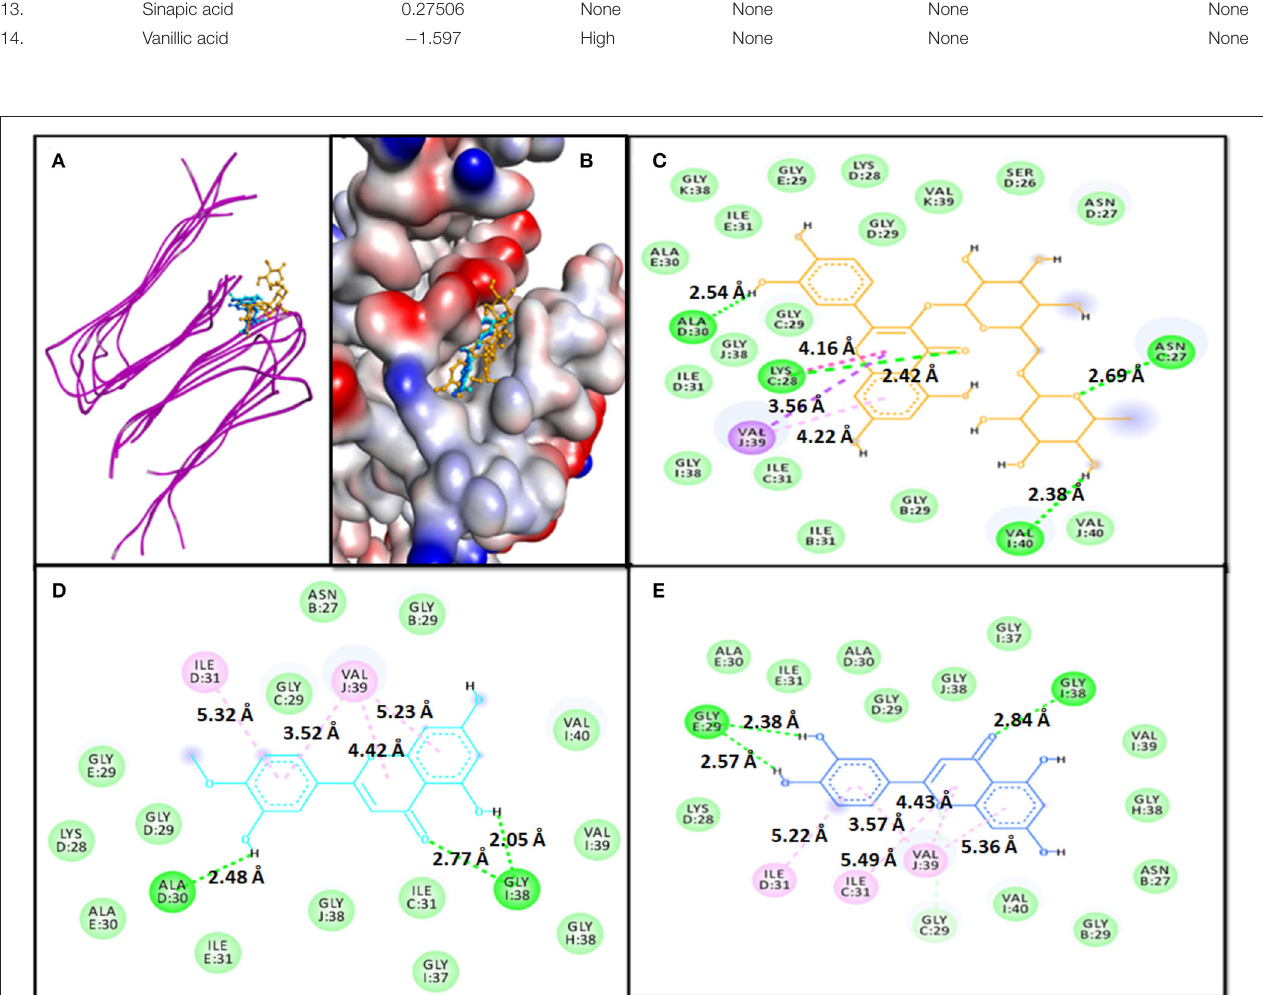
FIGURE 1 | Molecular docking of 2LMO with phytochemicals. (A) 2D representation of the binding of phytochemical to 2LMO, (B) 3D representation of the binding of phytochemical to 2LMO, (C) Interaction between 2LMO and Rutin, (D) Interaction between 2LMO and Diosmetin, and (E) Interaction between 2LMO and Luteolin.